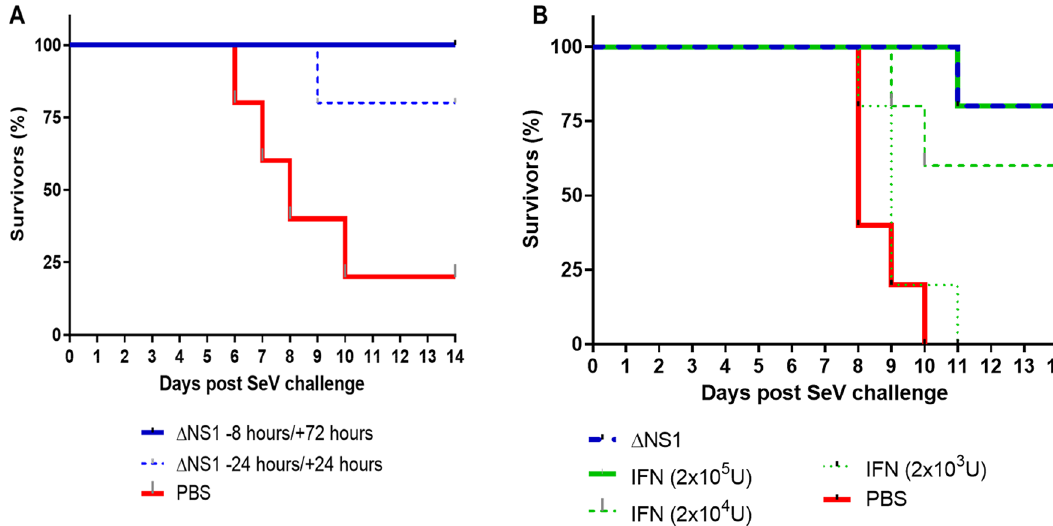
Figure 5. Treatment with ΔNS1 influenza virus protects C57BL/6 mice against lethal infection with Sendai virus. All mice were challenged intranasally with a lethal dose of Sendai virus corresponding to ( A ) 5 × 10 5 PFU or ( B ) 1.5 × 10 5 PFU. The percentage of mice surviving the challenge is represented. ( A ) Groups of five mice were treated intranasally with 2.5 × 10 5 PFU of ΔNS1 virus at the indicated times. ( B ) Groups of five mice were intranasally treated at − 24 h and + 24 h with respect to the infection with Sendai virus with 2.5 × 10 5 PFU of ΔNS1 or with the indicated amounts of